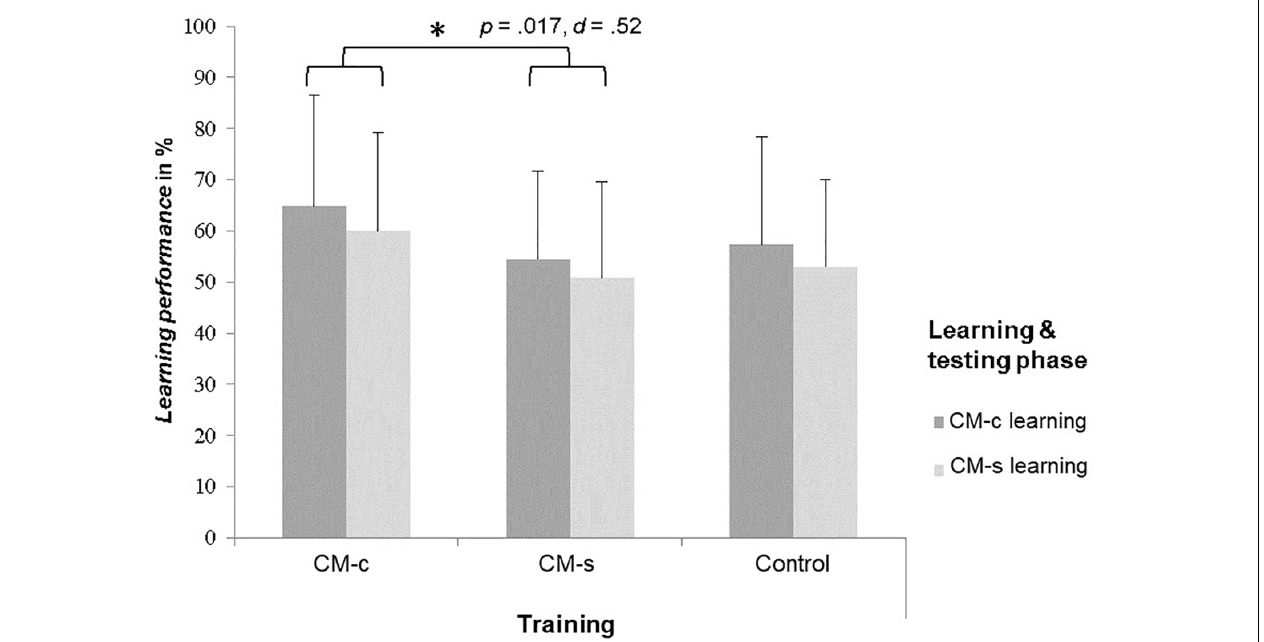
FIGURE 2 | Learning performance. CM-c, concept map construction; CM-s, concept map study.